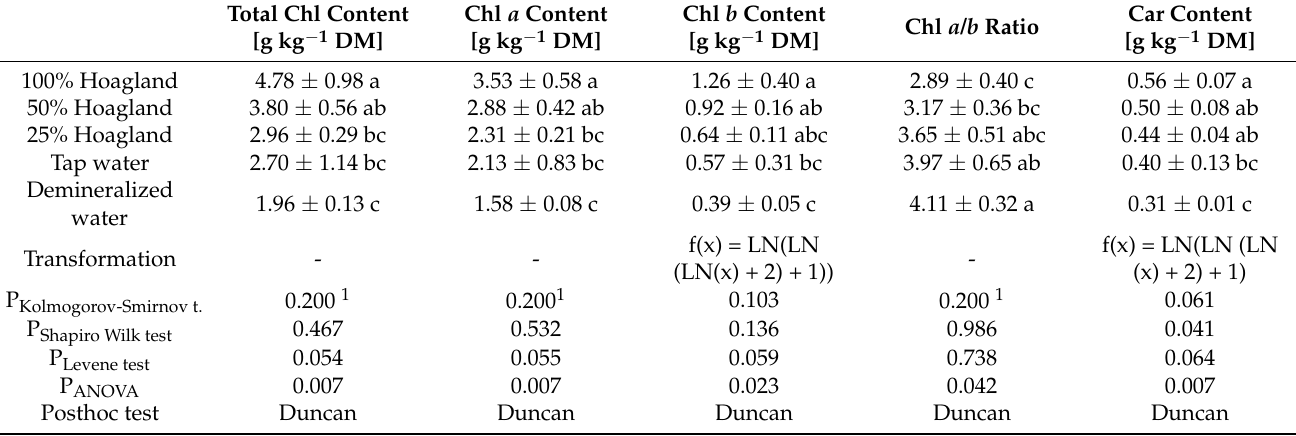
Table 9. Content of pigments in garden cress in g kg − 1 dry mass (DM). Different letters within a column indicate significant